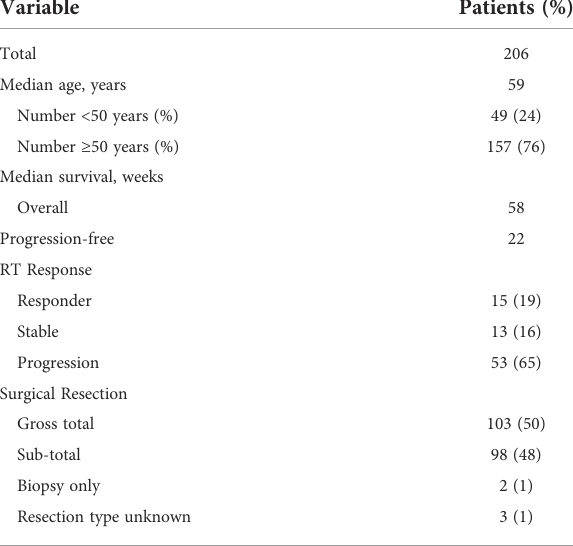
TABLE 1 GBM patient characteristics.